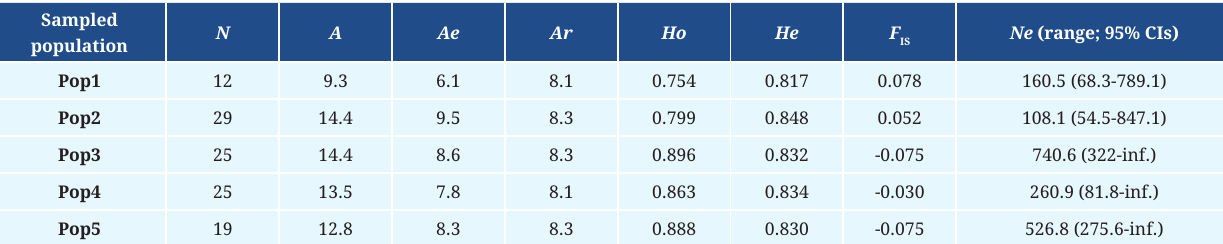
TABLE 1 | Summary of genetic diversity estimates in Salminus brasiliensis based on eleven microsatellite loci. N : samples size; A : mean number of alleles; Ae : No. of effective alleles; Ar : allelic richness; Ho : observed heterozygosity; He : expected heterozygosity; F inbreeding coefficient; Ne : effective population size (using a standardized sample size (N = 30) by simulating new individuals for each specific population); Inf: